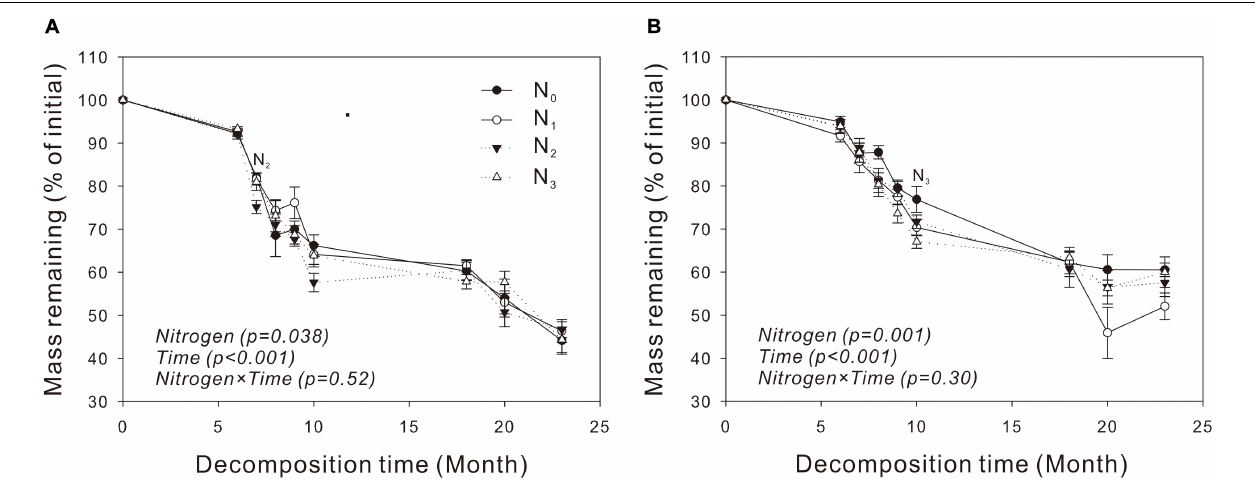
FIGURE 1 | Dynamics of the remaining mass in leaf litter of Vitex negundo (A) and Spiraea trilobata (B) at different N addition levels during the whole experimental period. Text in italics indicates the effects of N and time, as well as their combined effects, based on the two-way ANOVA. N 1 , N 2 , and N 3 at each decomposition time indicate that the difference between the specified N treatments and the control (CK) was significant ( P < 0.05). Error bars represent the standard deviations of the means ( n = 3). N 0 , control; N 1 , low N; N 2 , moderate N; and N 3 , high N.